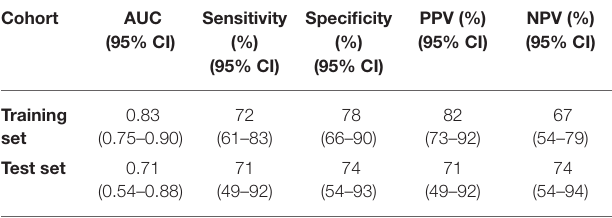
TABLE 2 | Area under the receiver-operating-characteristic curve, sensitivity, specificity, positive predictive value and negative predictive value of the 17-protein model to distinguish patients with and without late gadolinium